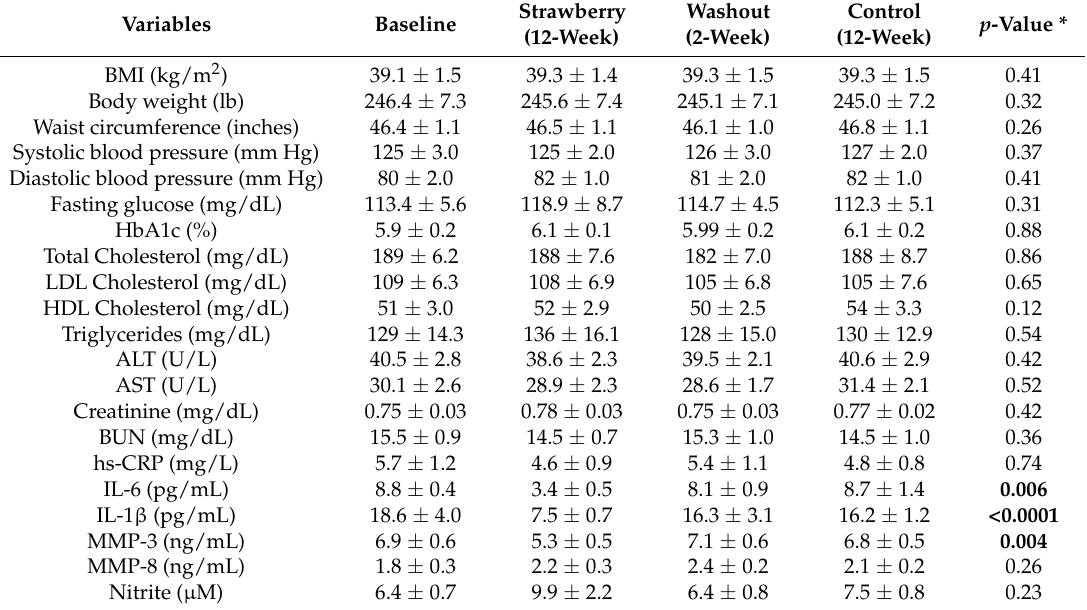
Table 4. Anthropometrics and serum biochemical and inflammatory profiles following strawberry and control interventions in a 26-week crossover trial in obese adults with symptomatic knee osteoarthritis ( n =